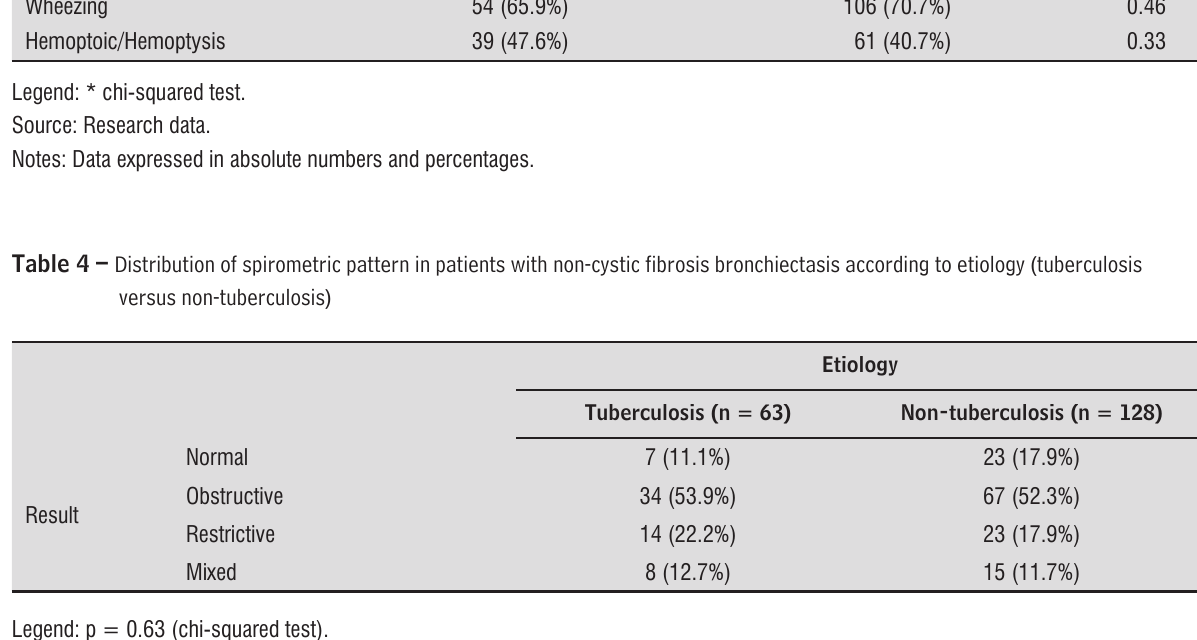
Table 3 – Symptoms observed in patients with non-cystic fibrosis bronchiectasis according to etiology (tuberculosis versus non-tuberculosis) Variable